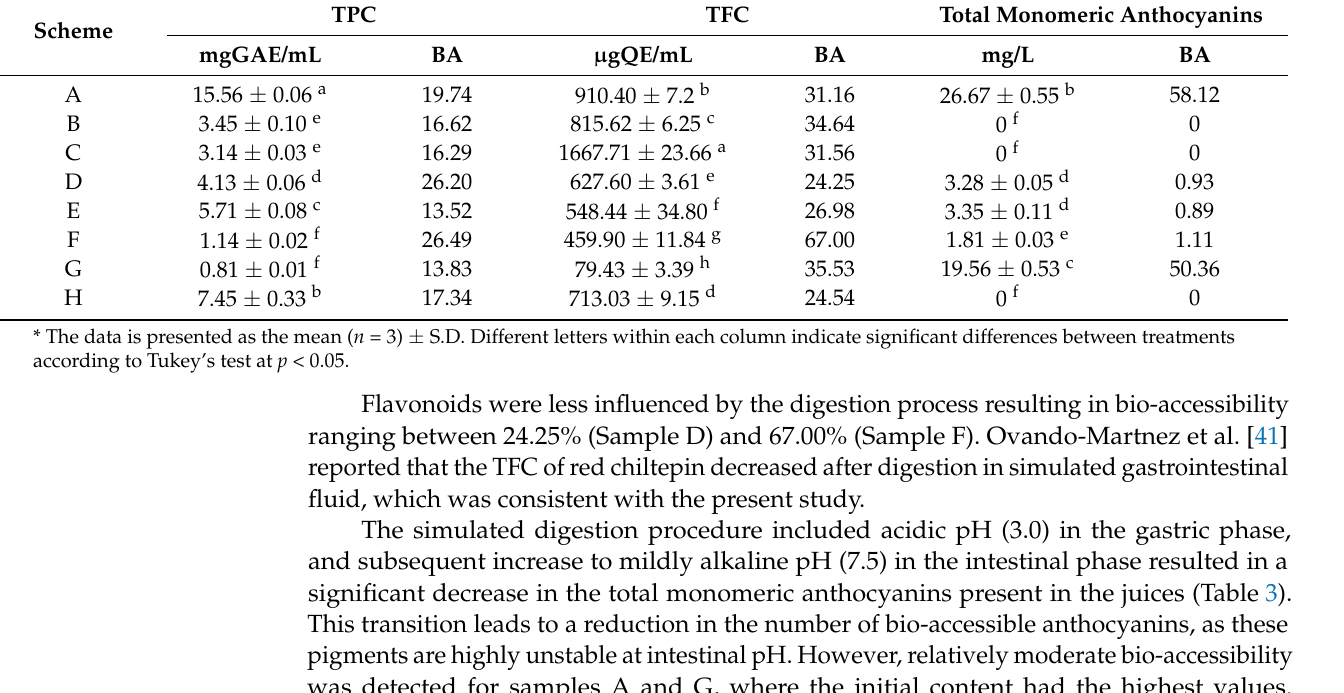
* The data is presented as the mean ( n = 3) ± S.D. Different letters within each column indicate significant differences between treatments according to Tukey’s test at p < 0.05.